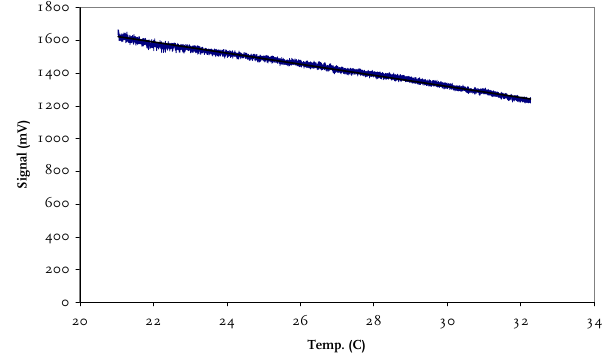
Fig. 8. Signal (mV) of the seeing photodiodes as a function of tem- perature ( ◦ C) in the luminol solution, for a constant amount of NO 2 (blue). The black line represents a linear fit through the measured points. The signal decreases with 2.0% per degree